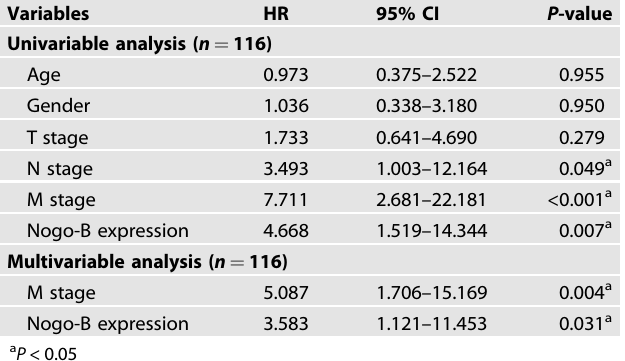
Table 2. Univariable and multivariable